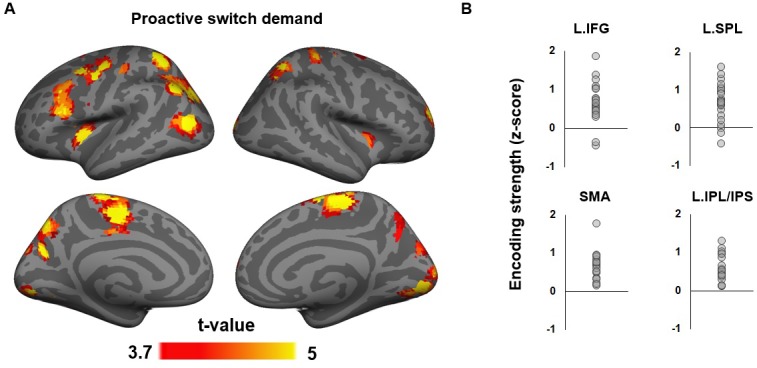
Neural encoding of proactive task switch demand.(A) T-statistics maps of brain regions showing significantly above-chance encoding of proactive task switch demand at the onset of the pre-cue. (B) Individual ROI-mean encoding strength of proactive task switch demand.